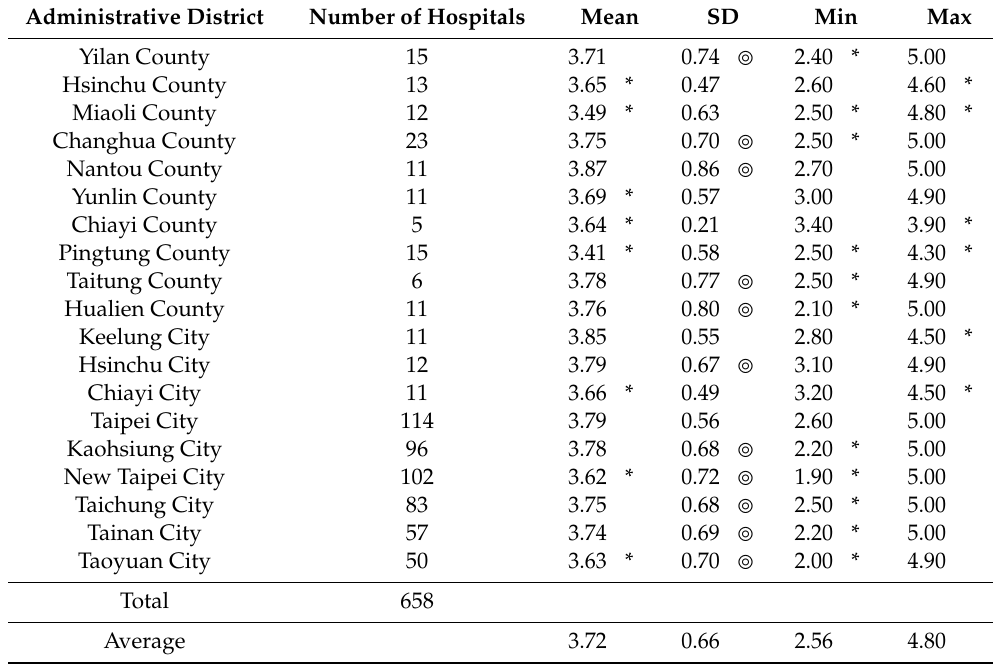
Table 3. Summary statistics of physical rehabilitation hospitals’ Google rating.